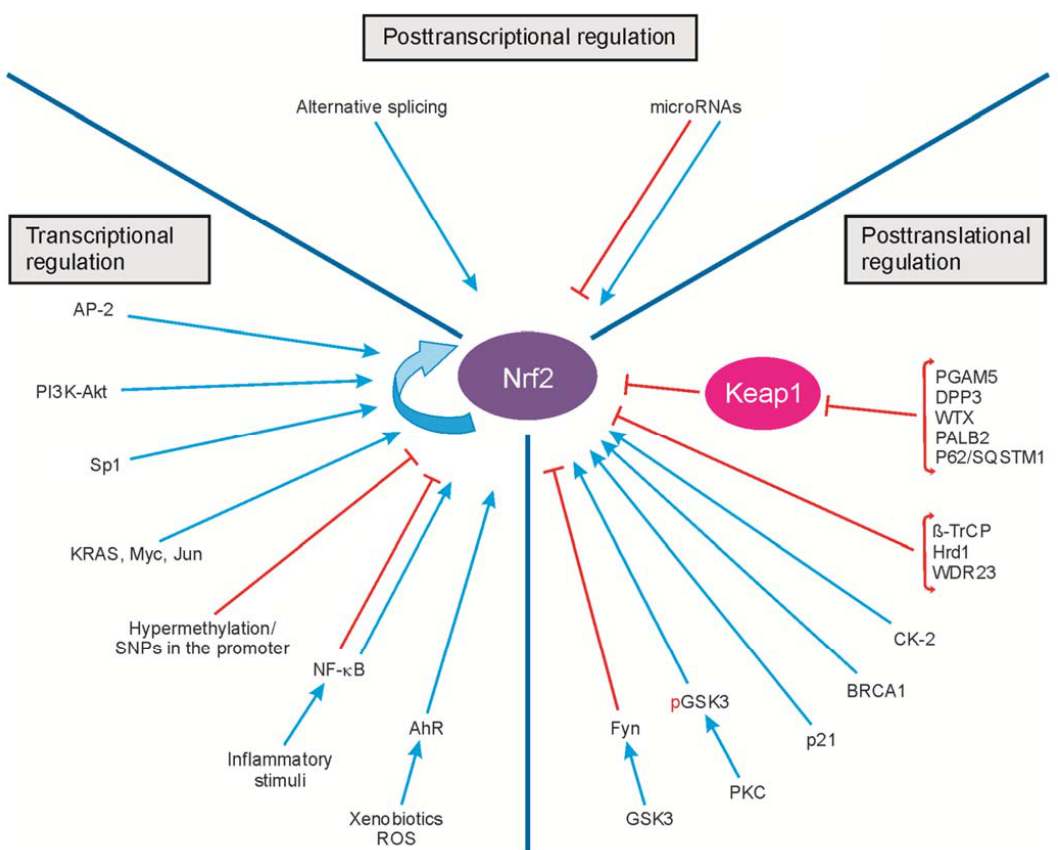
Figure 2. Transcriptional, posttranscriptional and posttranslational regulation of Nrf2 activity. The transcription of Nr2 is regulated by the transcription factors, oncogenes (KRAS, Myc, Jun) and modifications of the Nrf2 promoter (hypermethylation or SNPs). Posttranscriptional regulation includes alternative splicing and microRNA binding. The posttranslational control of Nrf2 activity results from protein modifications, protein degradation and protein–protein interactions. Arrows and blunt ends indicate activation and inhibition, respectively. ROS, reactive oxygen species; SNPs, single nucleotide polymorphisms; Akt, serine / threonine - protein kinase; BRCA1, breast cancer susceptibility 1; PI3K, phosphoinositide 3-kinase; NF- κ B, nuclear factor- κ B; AhR, aryl hydrocarbon receptor; Fyn, tyrosine-protein kinase Fyn; GSK-3, glycogen synthase kinase-3; pGSK-3, phosphorylated glycogen synthase kinase-3; KRAS, GTPase KRas; Myc, Myc proto-oncogene protein; J un, transcription factor AP-1; AP-2, activating enhancer-binding protein 2; Sp1, specificity protein 1; PKC, protein kinase C; CK-2, casein kinase 2; β -TrCP, β -transducin repeat-containing protein; Hrd1, HMG-CoA reductase degradation 1; WDR23, WD-repeat protein 23; PGAM5, phosphoglycerate mutase 5; DPP3, dipeptidyl peptidase 3; WTX, Wilms tumor gene on the X chromosome; PALB2, partner and localizer of BRCA2; p21, cyclin-dependent kinase inhibitor 1; p62/SQSTM1, sequestosome 1. Figure adapted from [67].